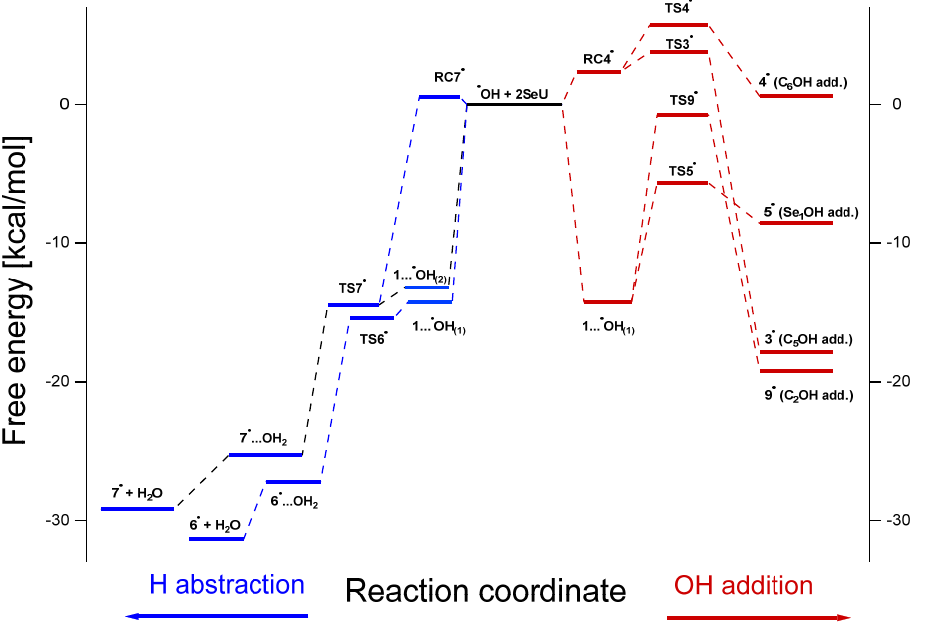
Figure 11. Relative energy profiles for the H abstraction (blue) and OH addition (red) from/to neu- tral 2-SeU, respectively, computed at ω B97x/aug-cc-pvtz-pp level of theory in aqueous phase